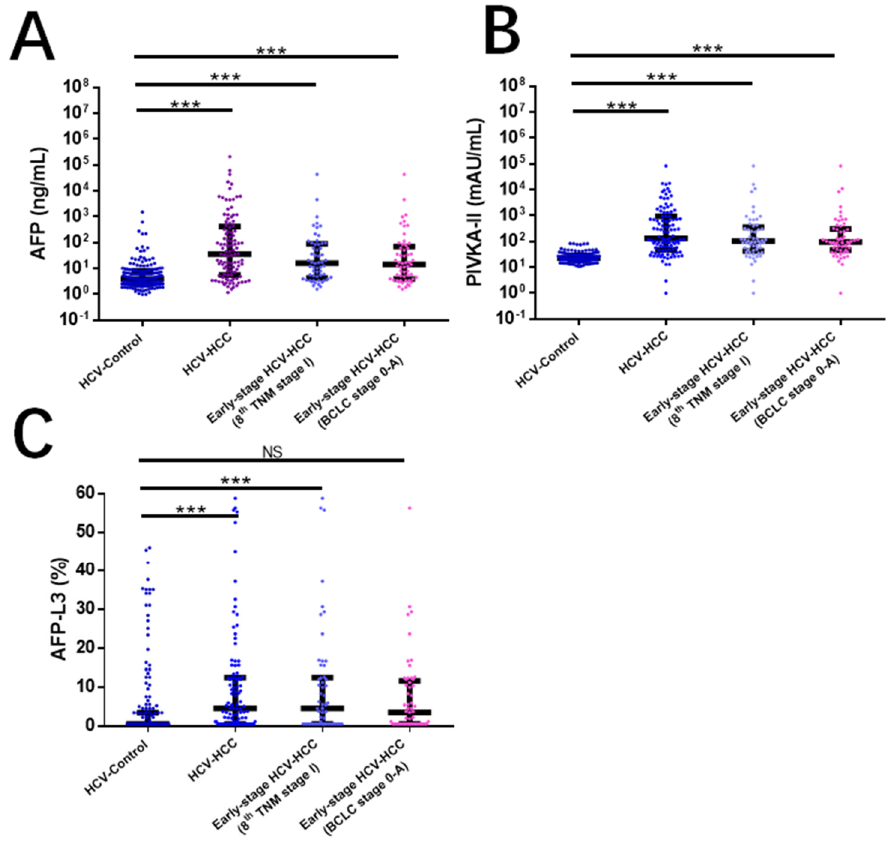
Figure 1. Serum concentrations of three HCC biomarkers. ( A ) AFP; ( B ) PIVKA-II; ( C ) AFP-L3. *** p < 0.001; NS, not significant.